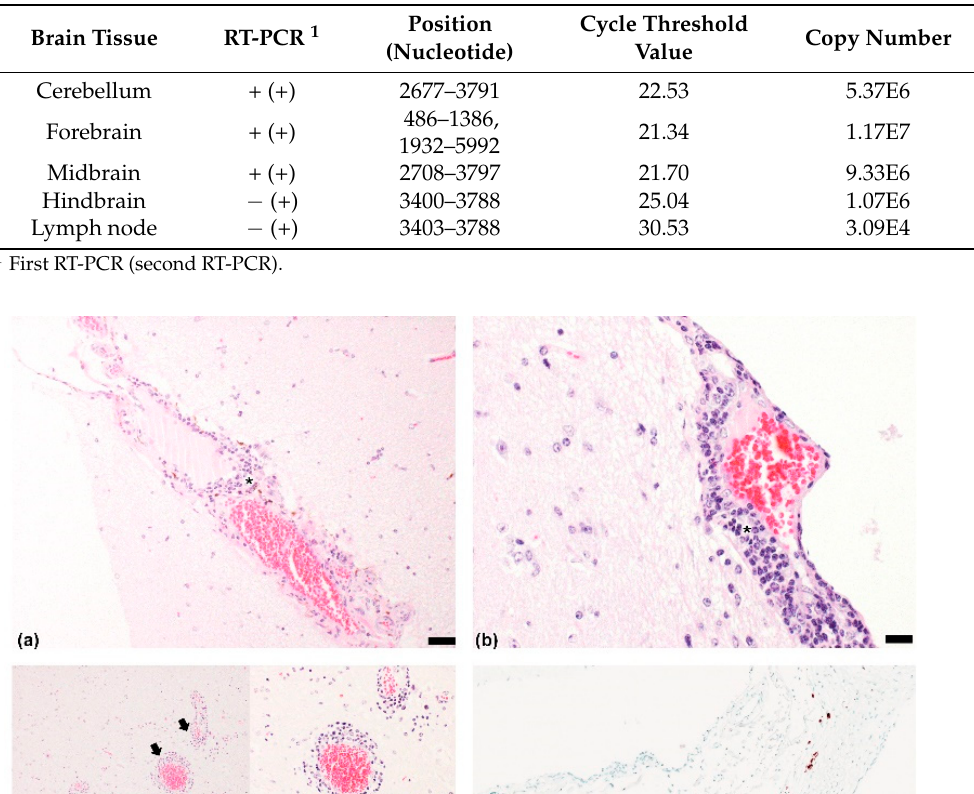
Table 1. Detection of astroviral RdRp from brain tissues of 20B05 cattle.